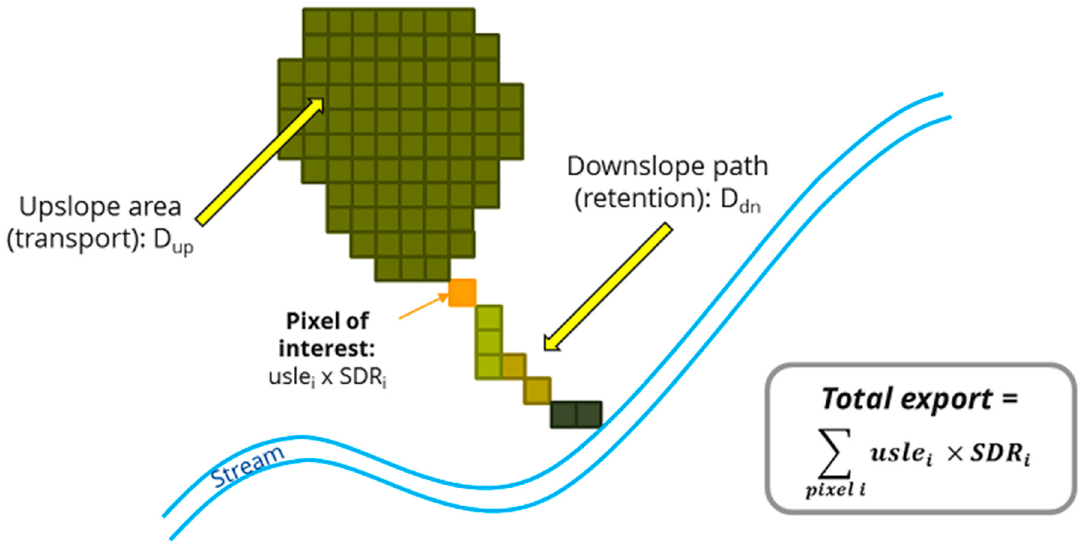
Figure 2. The conceptual approach of Integrated Valuation of Ecosystem Services and Tradeoffs (InVEST) Sediment Delivery Ratio (SDR) for calculating the estimated sediment export per pixel. (adapted from InVEST Natural Capital Project) [34].